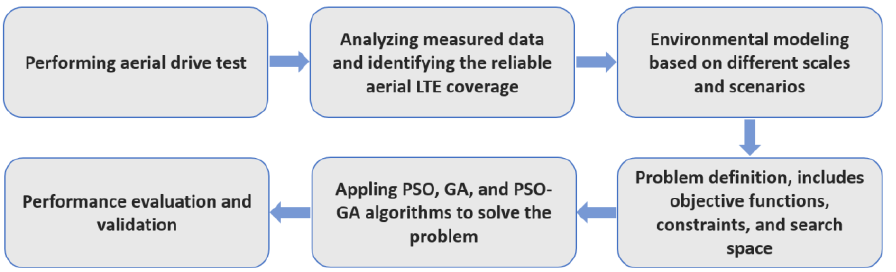
Figure 2. General flowchart of the methodology.